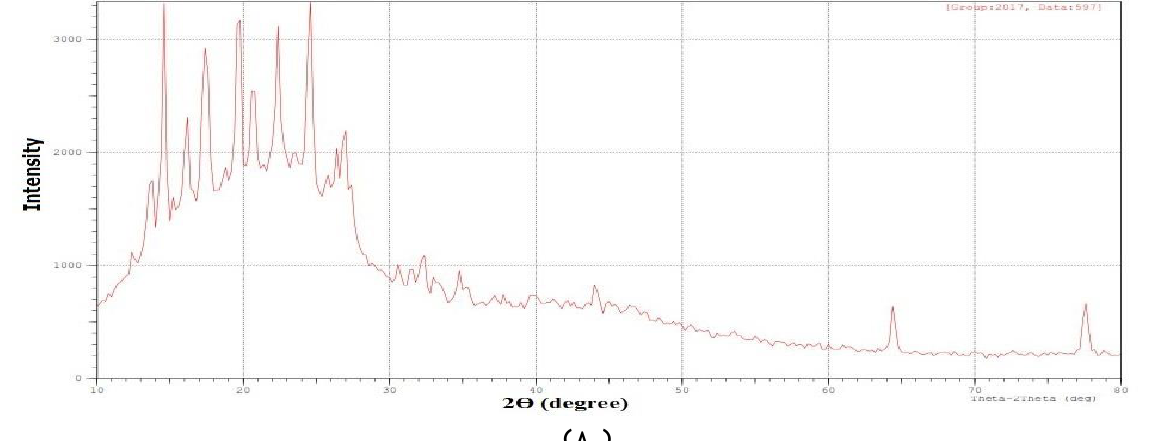
(Figure.1:c) ratio gave peaks with highest intensity than those prepared using (1:4 or 1:6) solvent: anti- solvent ratio